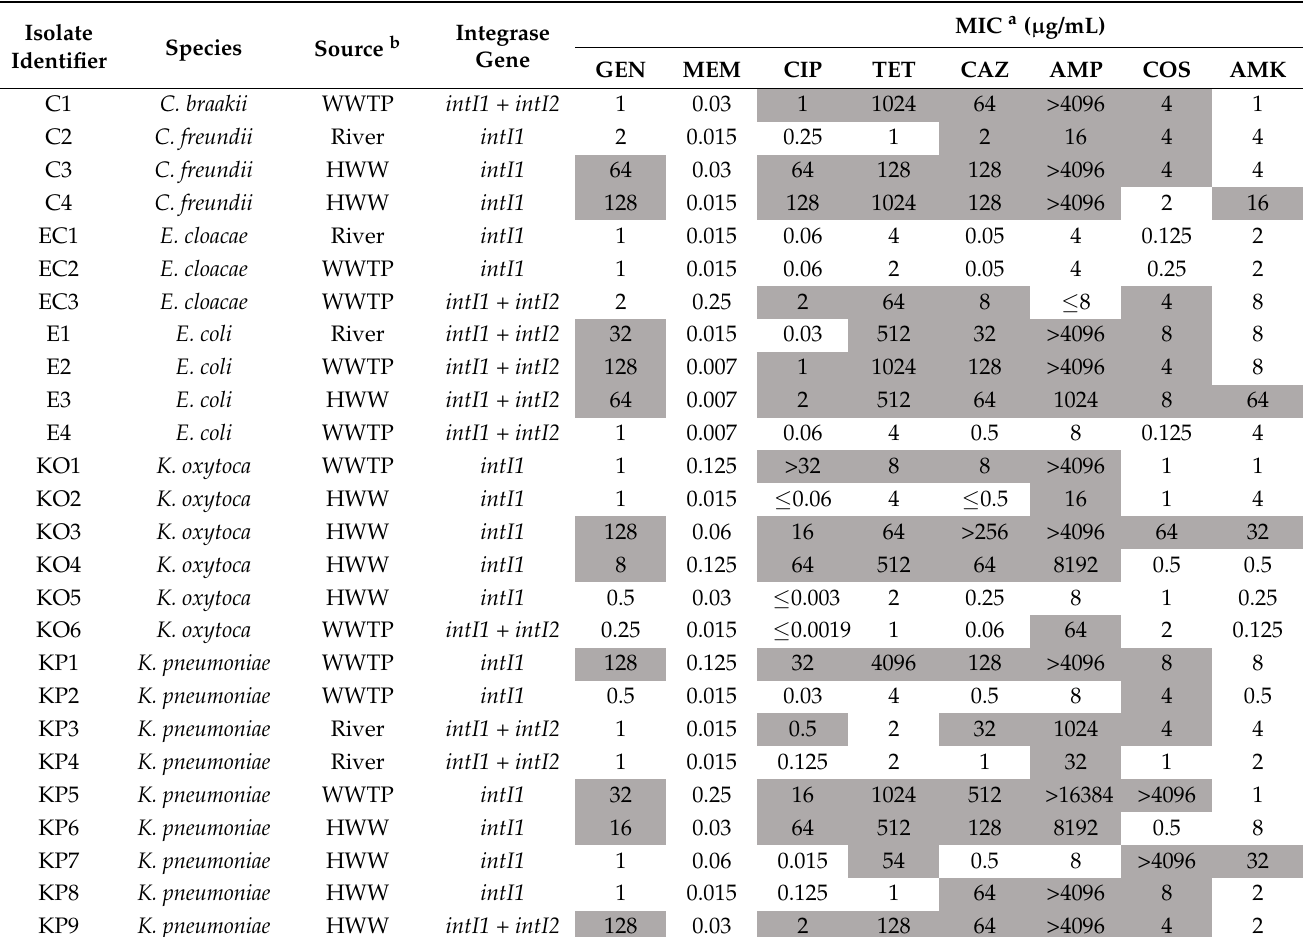
a The shaded portions indicate MIC values classified as resistant, while the unshaded areas indicate those classified as susceptible. GEN: gentamicin, MEM: meropenem, CIP: ciprofloxacin, TET: tetracycline, CAZ: